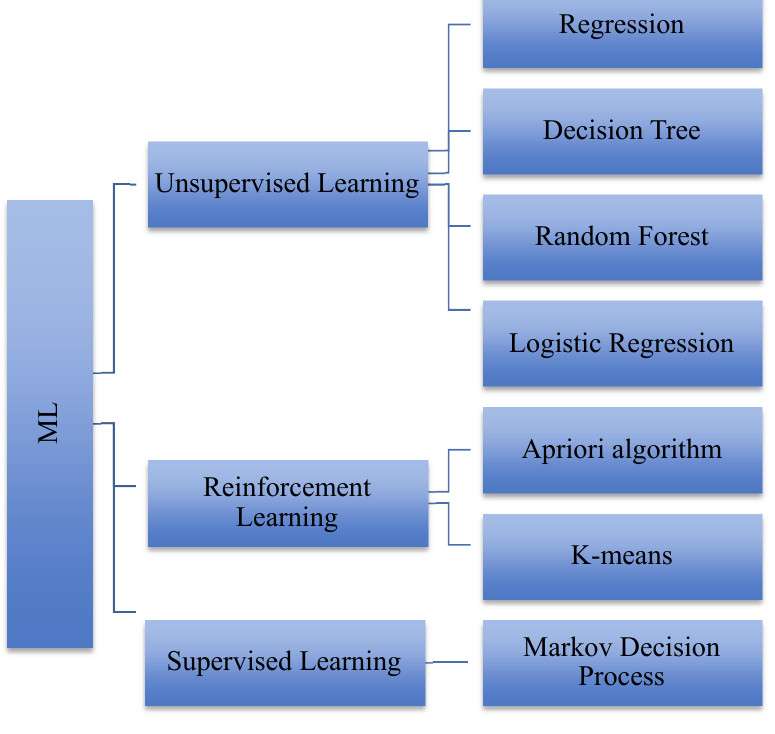
Fig. 3. Categories of Machine Learning